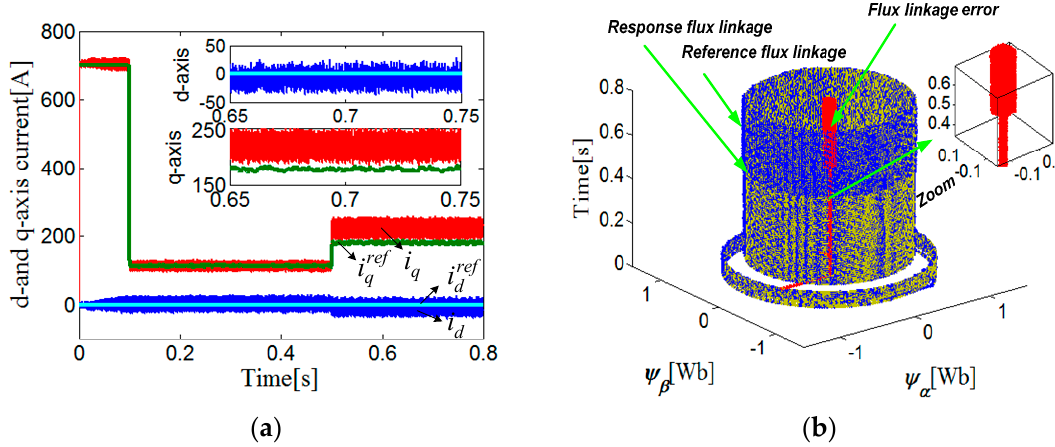
Figure 8. Simulation results of the conventional PCC method under inductance and flux linkage parameter perturbation. ( a ) d ‐ and q ‐ axis current responses and references; ( b ) three ‐ dimensional rotor flux trajectories.